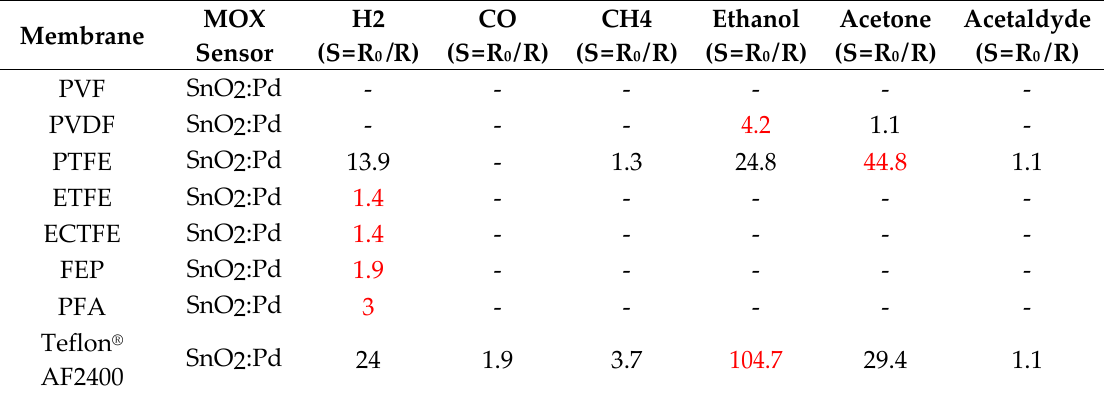
Table 1. Permeate signals of the MOX sensors combined with PVF, PVDF, PTFE, ETFE, ECTFE, FEP, PFA and Teflon ® AF2400 membranes. The given signal ratios (S = R 0 /R) are the arithmetic mean of three measurements. The exposure time was 20 min. The values marked in red show filters with a high selectivity to a specific